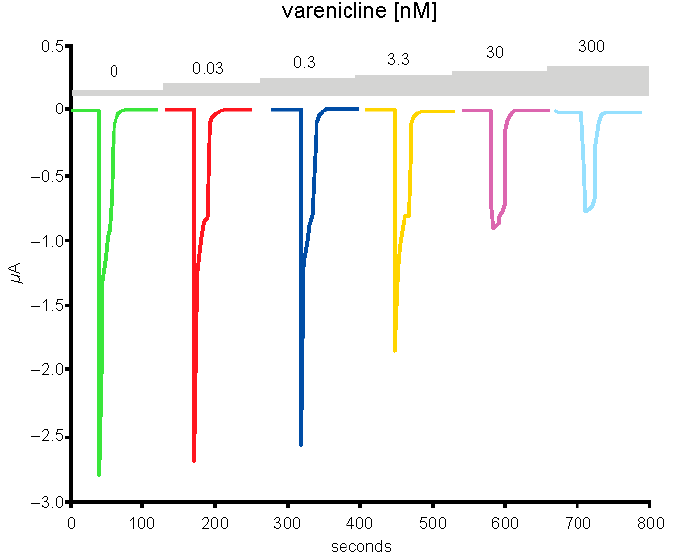
Figure 7. Exposure to low, but sustained, applications of varenicline desensitize the human α 4 β 2 nicotinic acetylcholine receptor. Typical currents evoked by brief acetylcholine test pulses (50 µM) were recorded in a cell expressing the complementary DNA encoding for the human α 4 β 2 receptors were recorded first in control conditions (green trace) and then during exposure to a series of varenicline concentrations ranging from 0.03 to 300 nM.